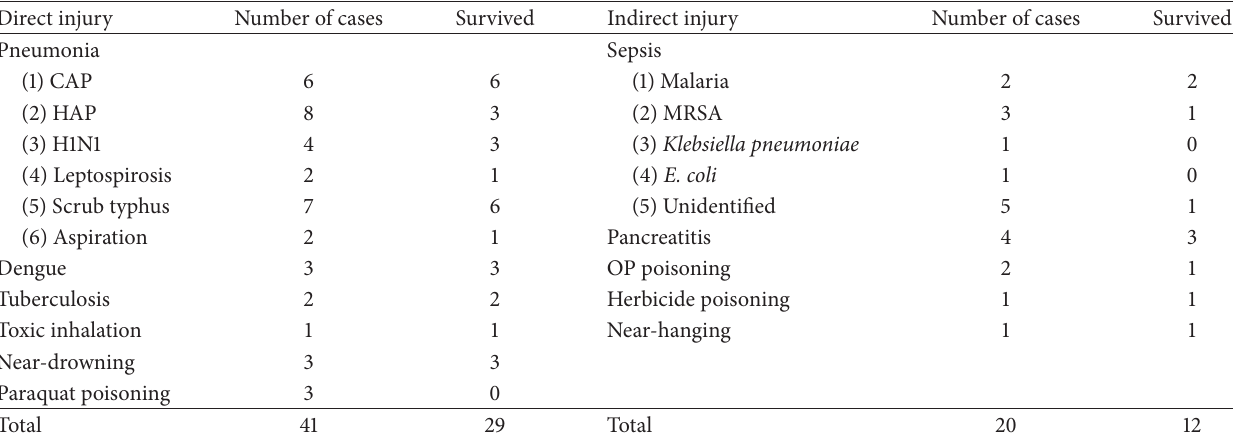
Table 1: Etiology and survival of patients in our study.